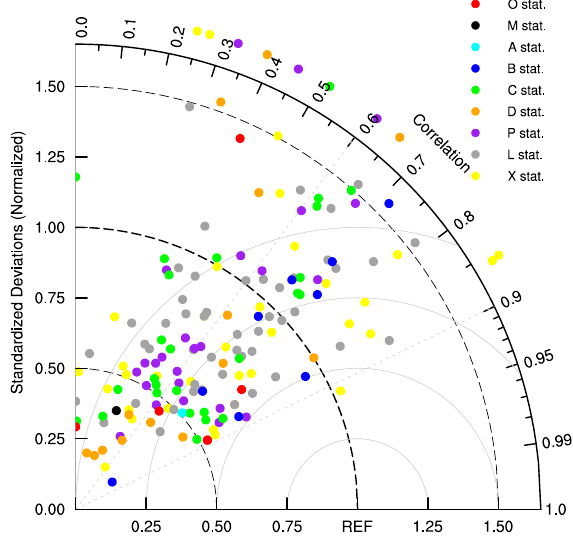
Figure 14. Taylor diagram (Taylor, 2001) for the AOD monthly time series of 166 AERONET stations and outputs from the diagram ( Taylor , 2001) for the AOD monthly time series of 166 AERONET sta- Fig. 14. Taylor NudSimd2_Trans simulation (see text for details). The qualifica- tions and ouputs from the NudSimd2 Trans simulation (see text for details). The qualification tion of the stations is that of Kinne et al. (2013) indicating the site’s of the stations is that of Kinne et al. (2013) indicating the site dominant aerosol category (O, dominant aerosol category (O, ocean; M, mountain; A, polar; B, ocean; M, mountain; A, polar; B, biomass; C, coastal; D, dust; P, polluted, L, land), and X, no biomass; C, coastal; D, dust; P, polluted, L, land), and X, no quali- qualification.